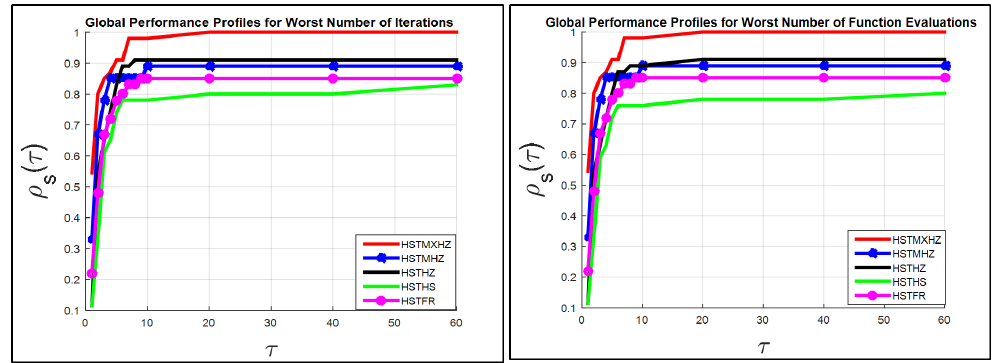
Figure 1. Worst number of iterations and function evaluations performance profile.